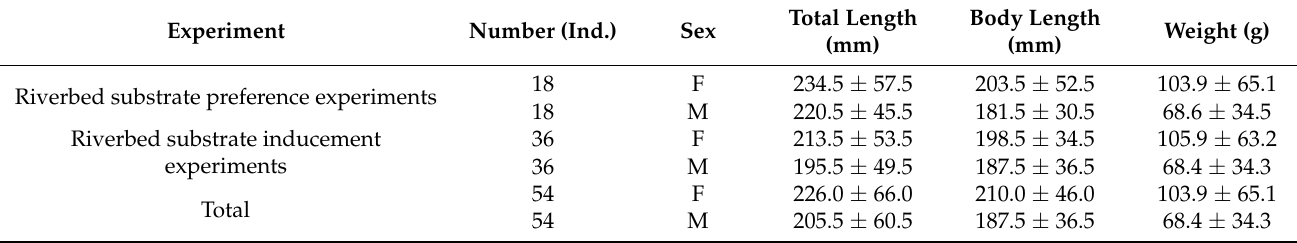
Table 1. Biological parameters of the experimental